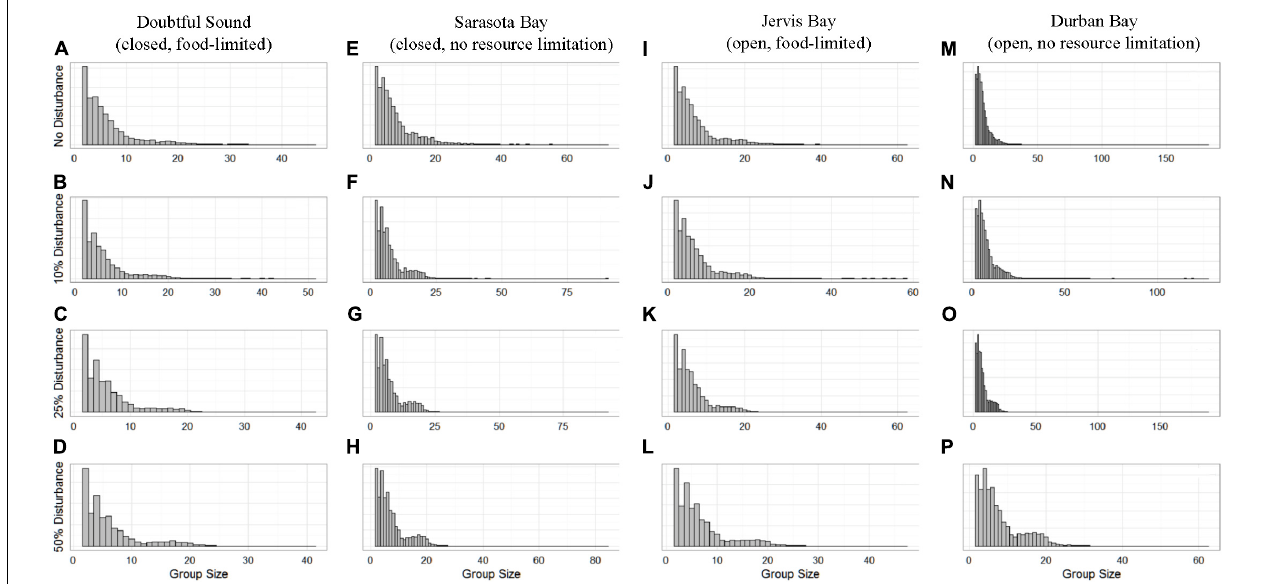
FIGURE 6 | The distribution of school sizes for the four simulated populations (columns), Doubtful Sound (A–D) , Sarasota Bay (E–H) , Jervis Bay (I–L) , and Durban Bay (M–P) , under four different disturbance scenarios (rows): no disturbance (A,E,I,M) and a 10% (B,F,J,N) , 25% (C,G,K,O) , or 50% (D,H,L,P) chance of an individual being disturbed when in the area used by whale-watching vessels